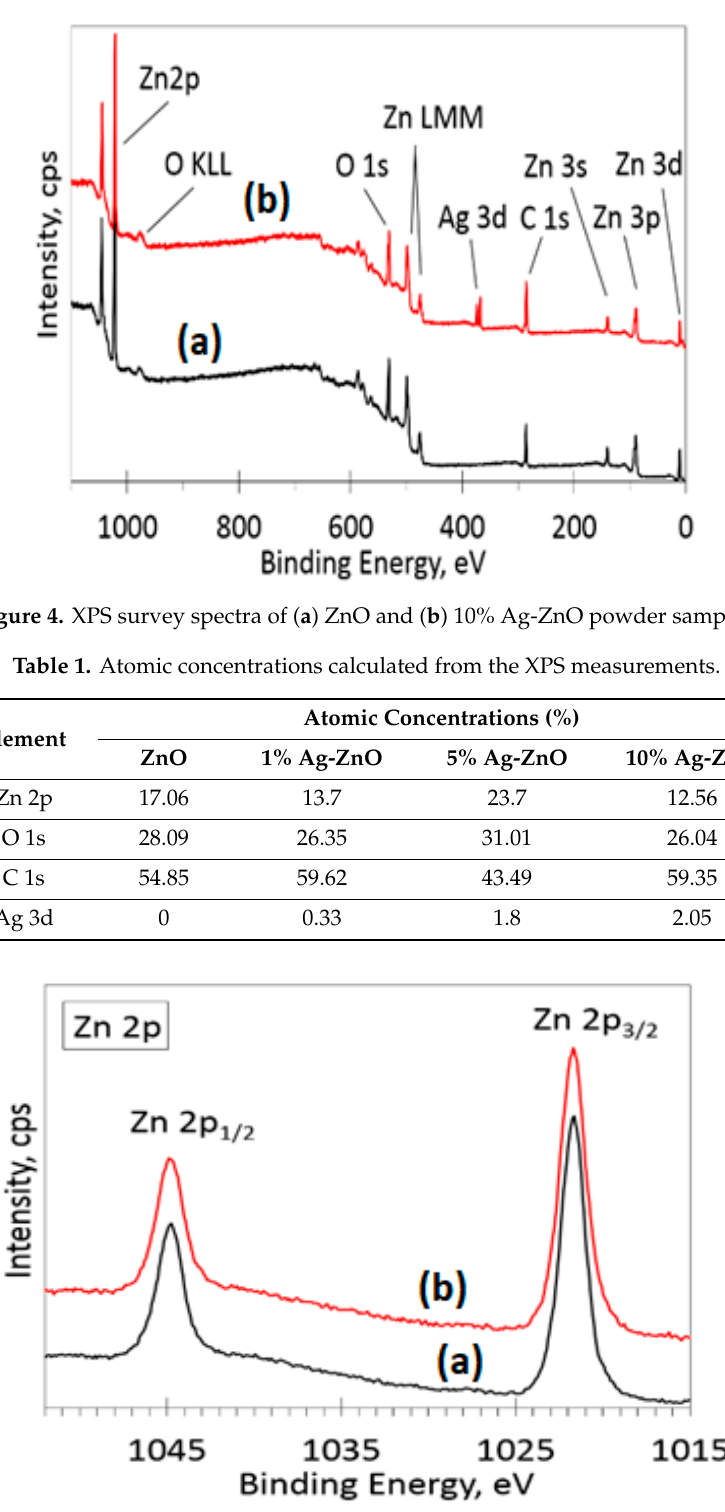
Figure 5. High-resolution XPS spectra in Zn 2p region for ( a ) ZnO and ( b ) 10% Ag-ZnO powder samples.